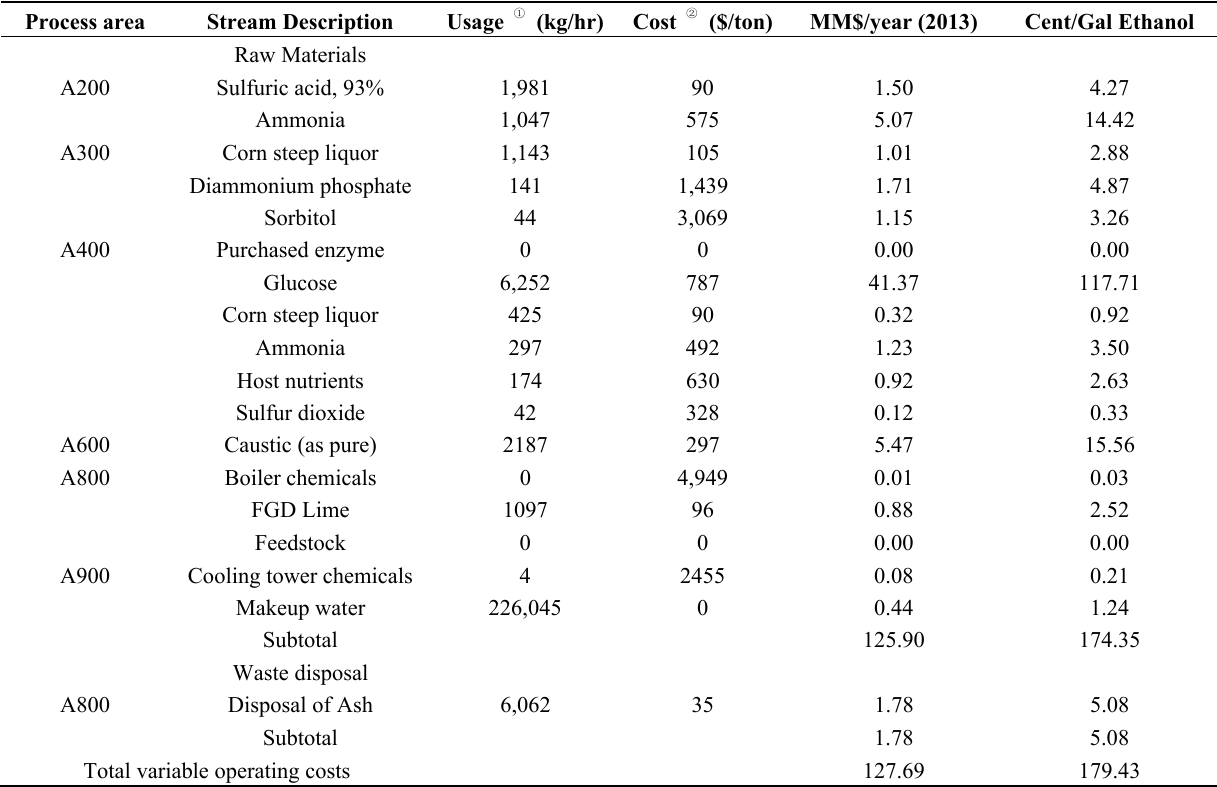
Table 10. Variable operating cost (Scenario CN_1).